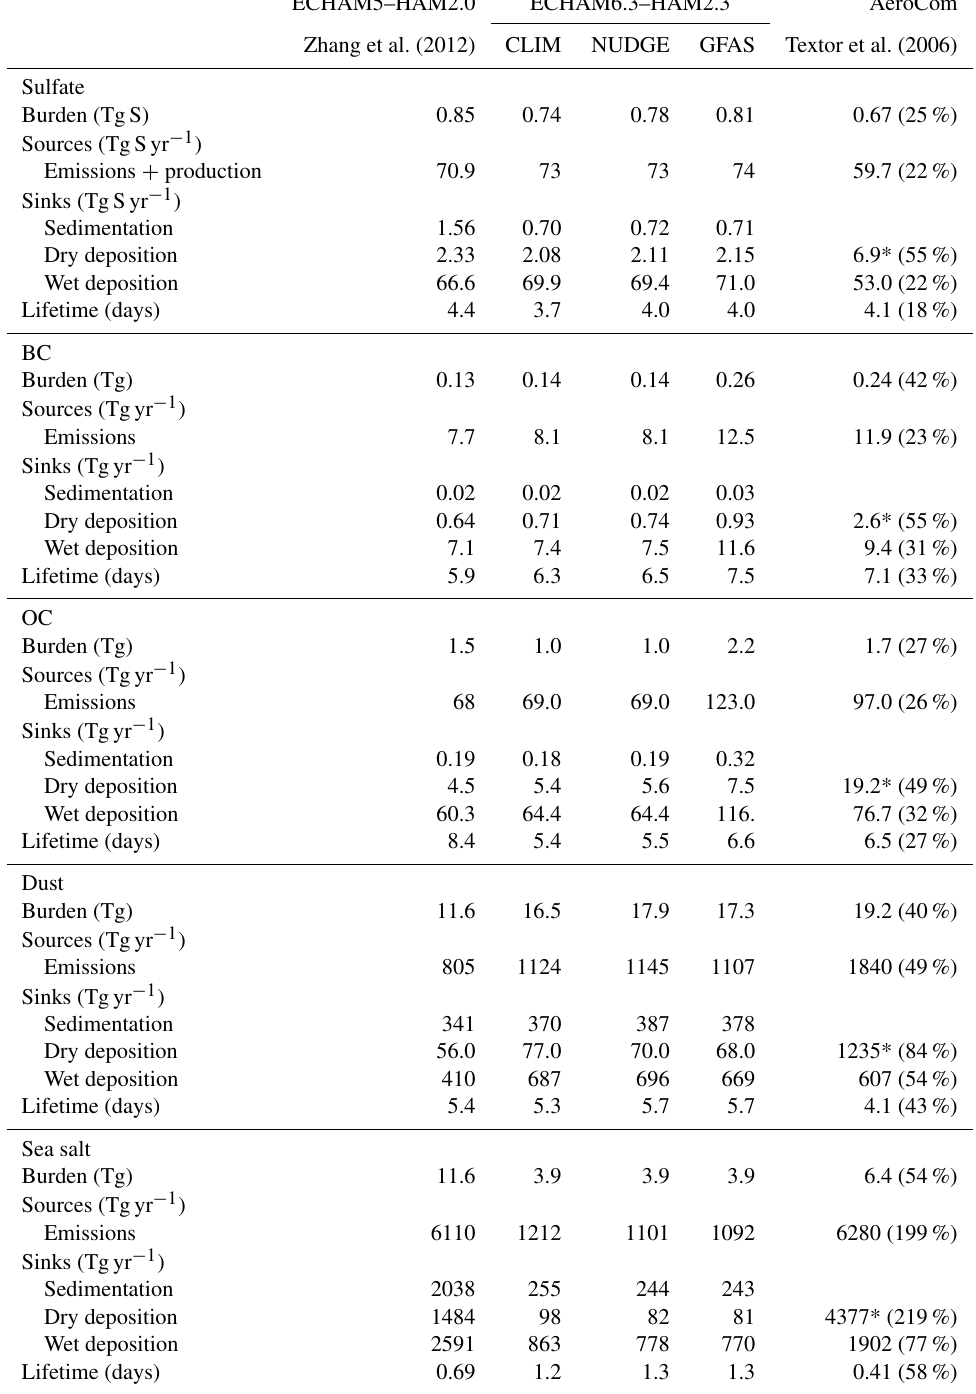
Table 3. Comparison of global annual aerosol budgets. Compared are the results from ECHAM6.3–HAM2.3 with the earlier version ECHAM5–HAM2.0 as described in Zhang et al. (2012) (Table 8 therein) and the simulations CLIM, NUDGE, and GFAS averaged over the years 2003–2012. The results are also compared with the multi-model AeroCom results by Textor et al.